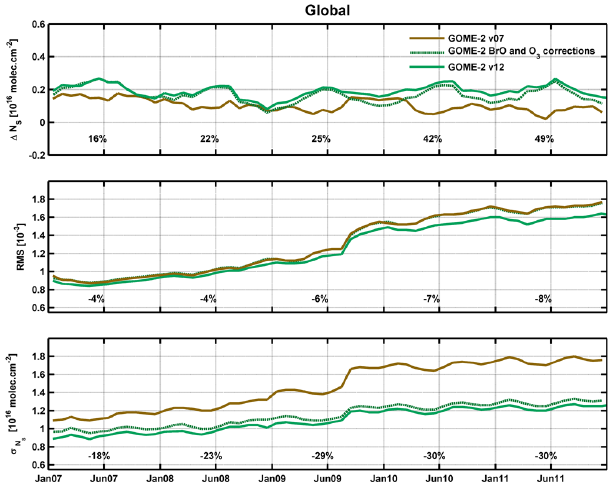
Fig. 7. Globally averaged time evolution of the normalized H 2 CO slant colums (first panel); the root mean square of the fit (second panel); and the H 2 CO slant columns standard deviation (third panel) for the intitial settings (v07), the BrO and O3 corrections, and the final improved GOME-2 retrieval settings, including the fit of the GOME-2 slit function (v12). Yearly averaged relative differences between GOME-2 v07 and v12 results are given at the bottom of each